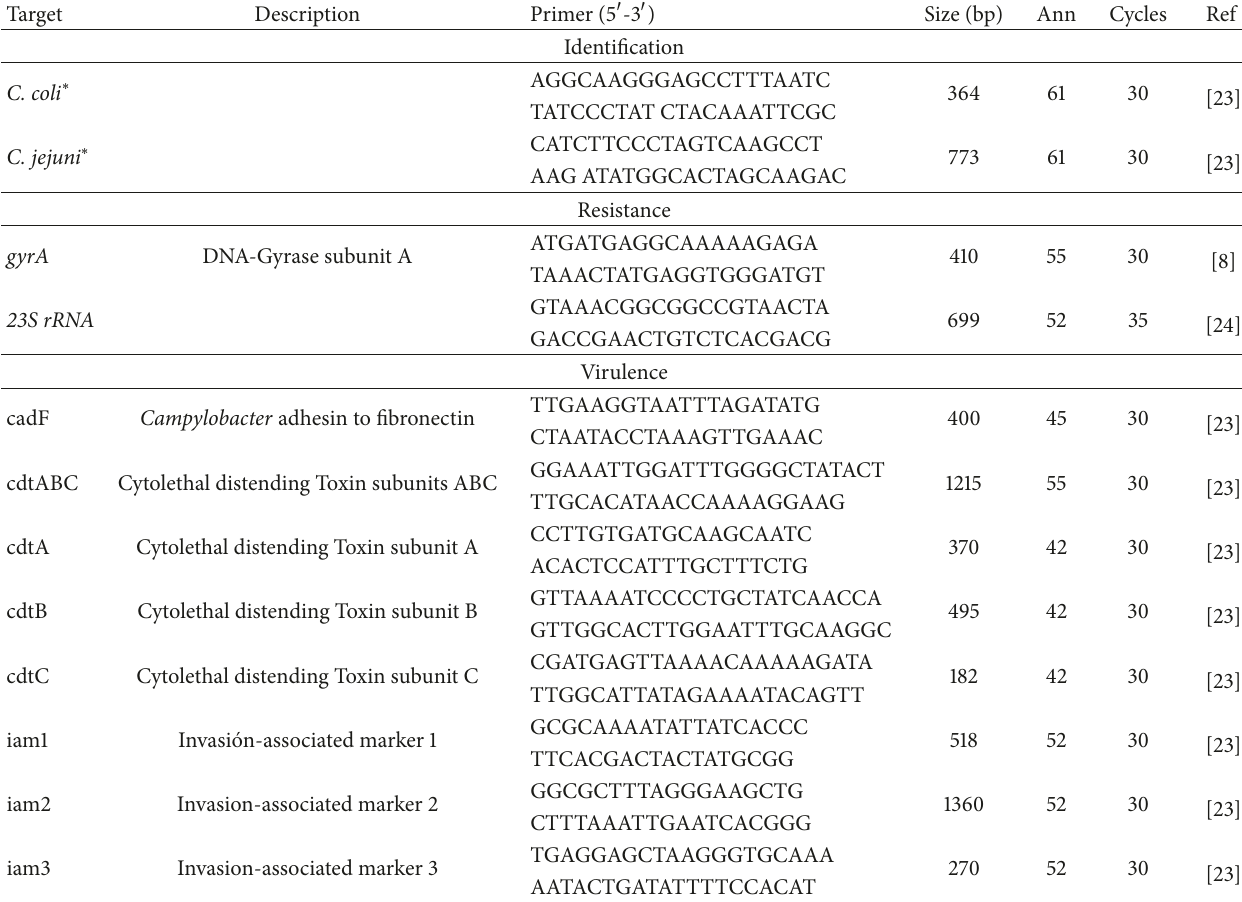
Table 1: Primers and PCR conditions used in the present study.